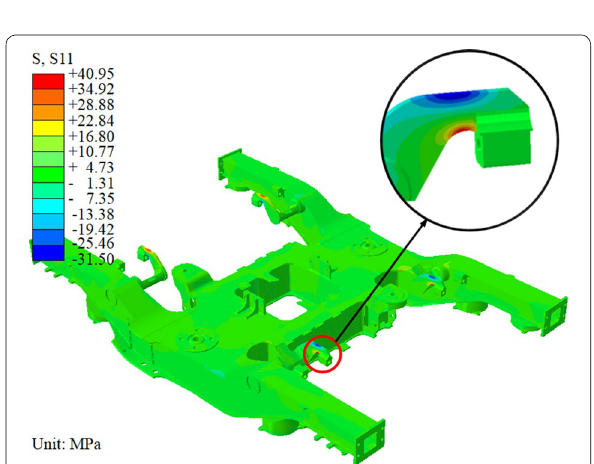
Figure 6 Bogie frame configuration, finite element meshes, and brake unit bracket considering a crack: a bogie frame, b brake unite bracket, c configuration of semi-elliptical crack